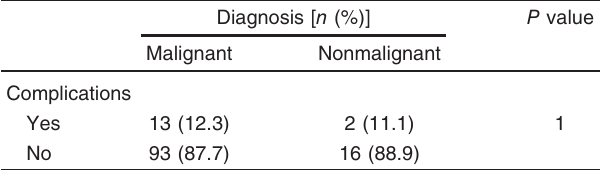
Table 5 Relation between diagnosis and complications